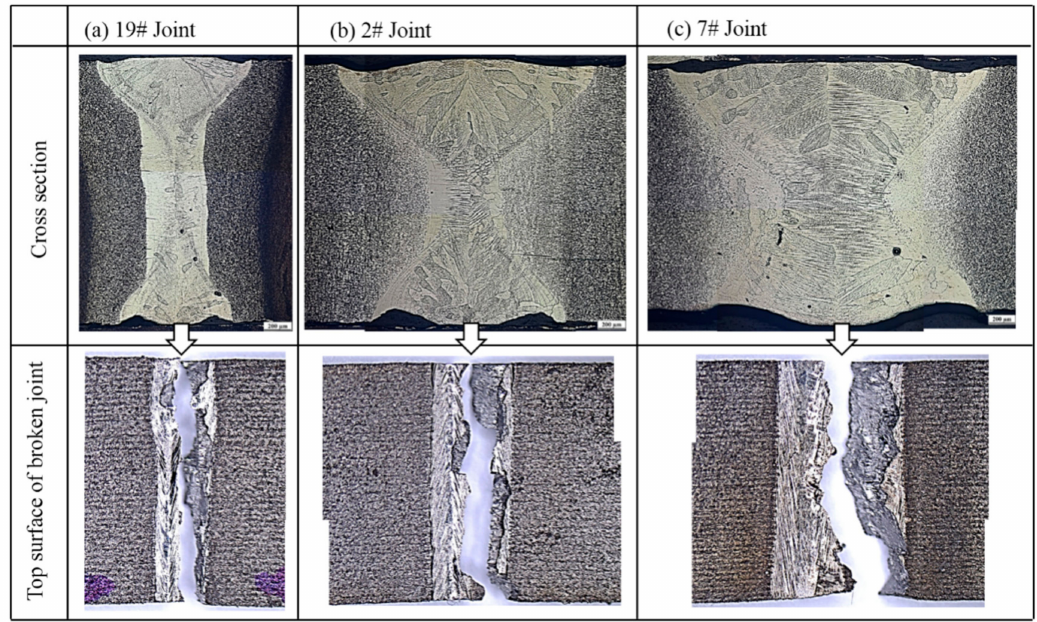
Figure 4. Morphologies of cross-sections of typical as-welded joints under OM. ( a ) #19: P = 3.5 kw, v = 4 m/min, f = 0 mm; ( b ) #2: P = 2 kw, v = 2 m/min, f = 0 mm, and ( c ) #7: P = 2.5 kw, v = 2 m/min, f = +3 mm.